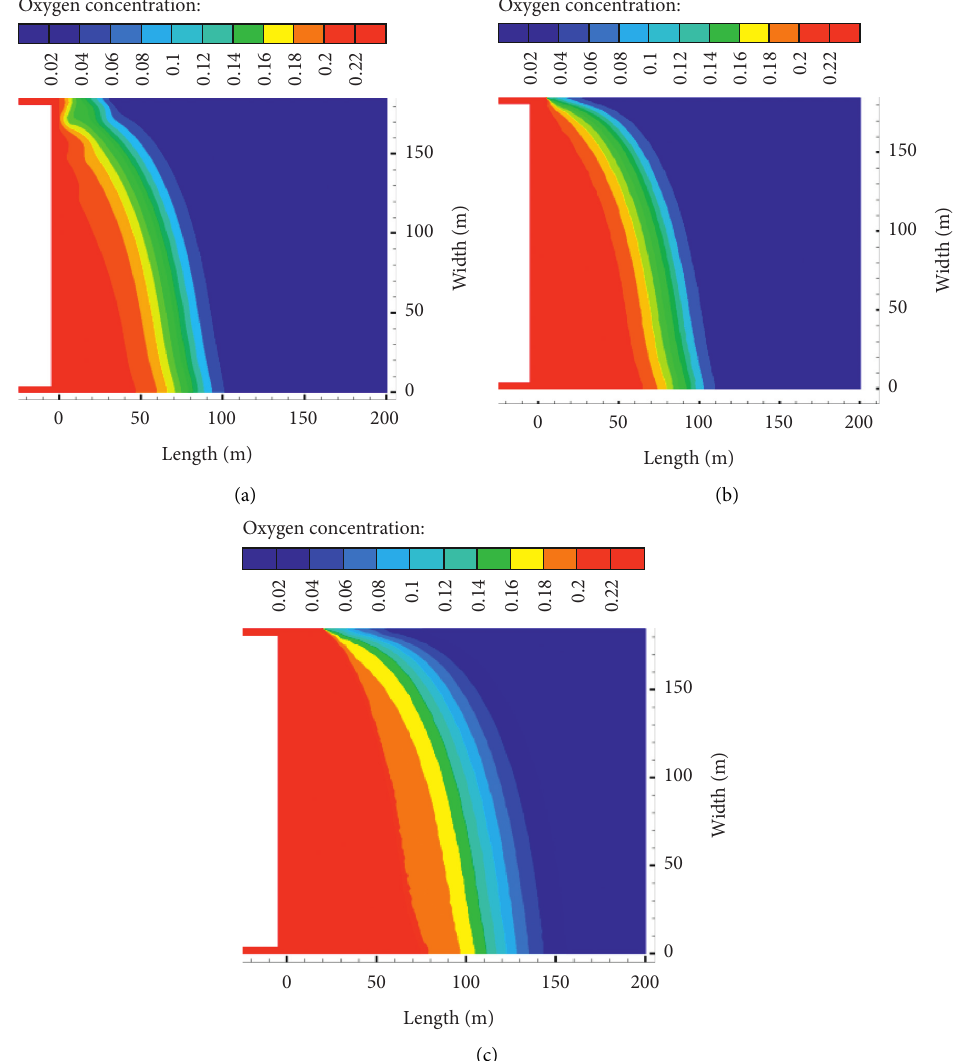
Figure 7: Distribution of spontaneous combustion zone in goaf. (a) Oxygen distribution without pumping. (b) Oxygen distribution